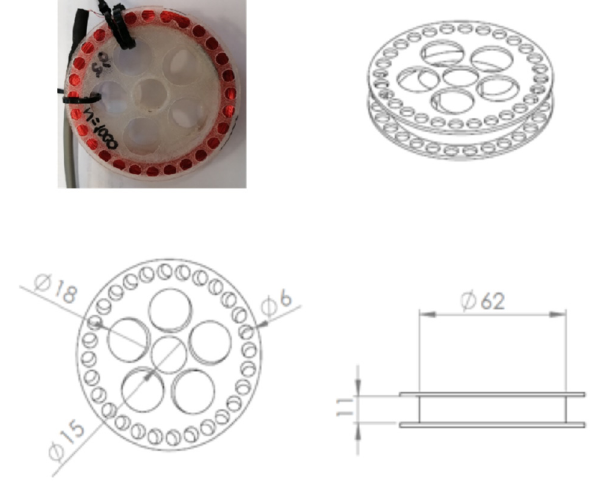
Figure 7. Shape and dimensions of the coil sensor used during the experiments.